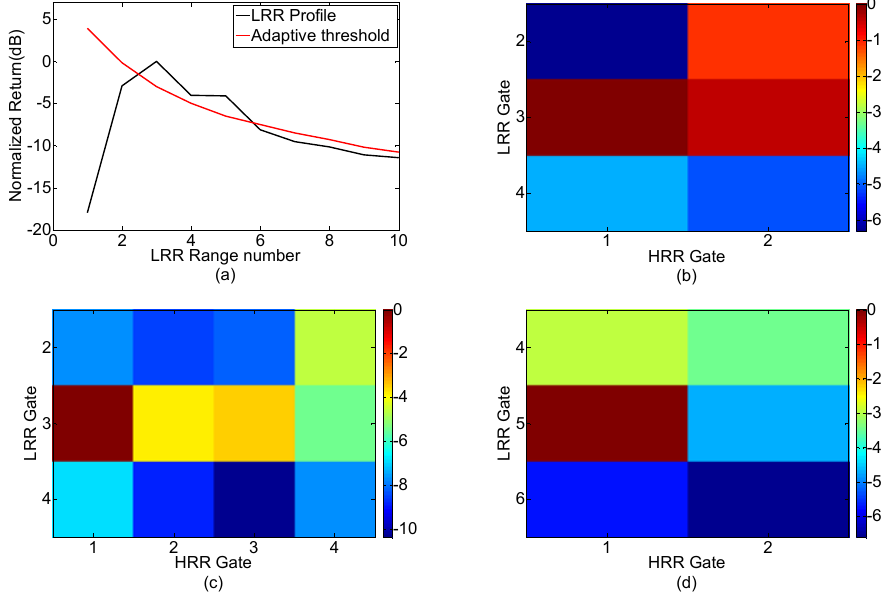
Figure 11. Imaging results for Target Scenario 4. ( a ) Pass 1. ( b ) Pass 2, LRR Gate 3. ( c ) Pass 3, LRR Gate 3. ( d ) Pass 2, LRR Gate